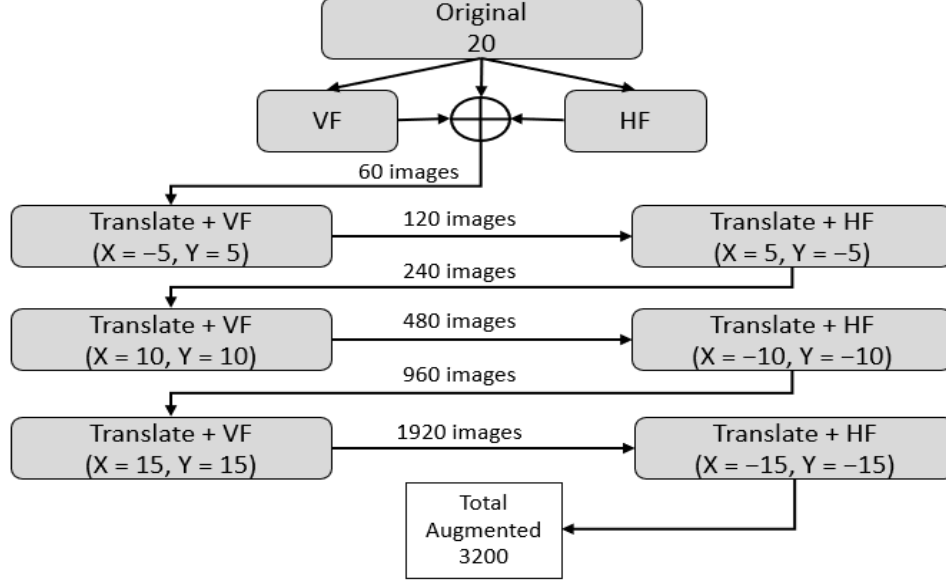
Figure 5. Data augmentation scheme used to synthetically increase training data, where VF and HF represent vertical flip and horizontal flip, respectively.